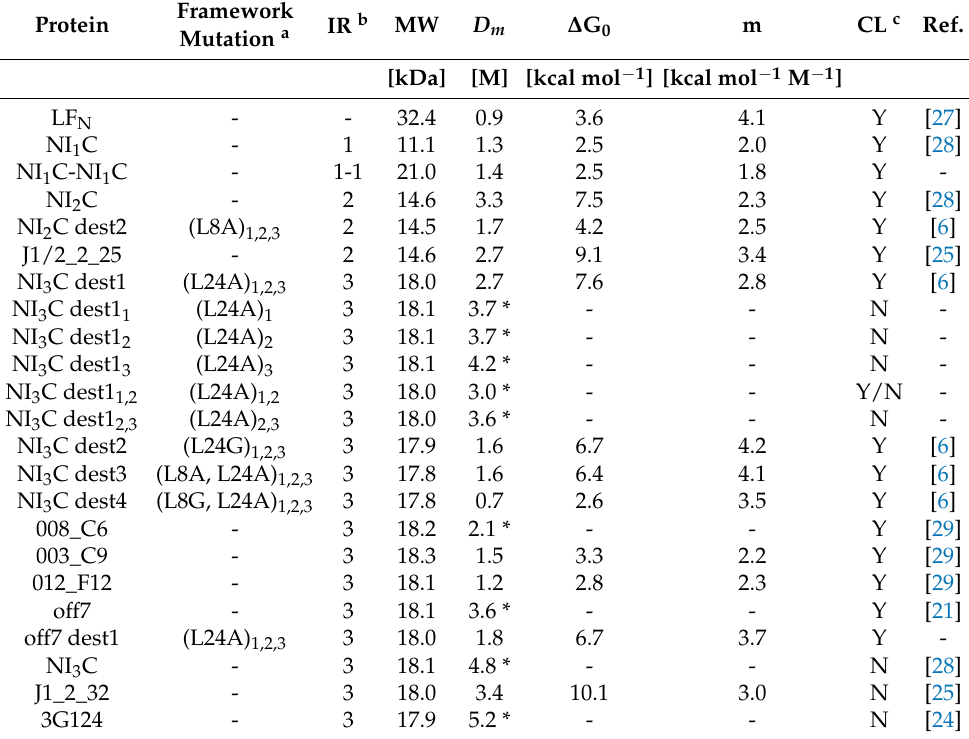
Table 1. Parameters characterizing different cargo DARPins and LF N .